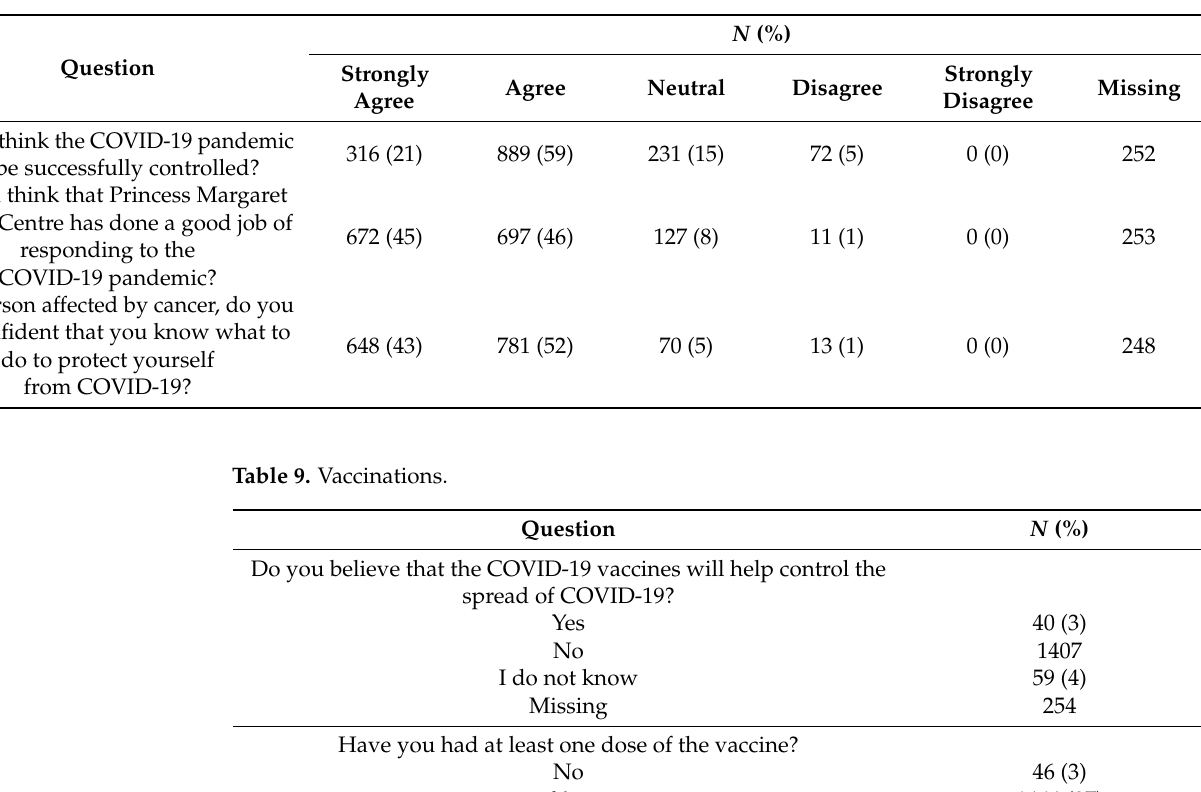
Table 8. Attitudes about COVID-19.